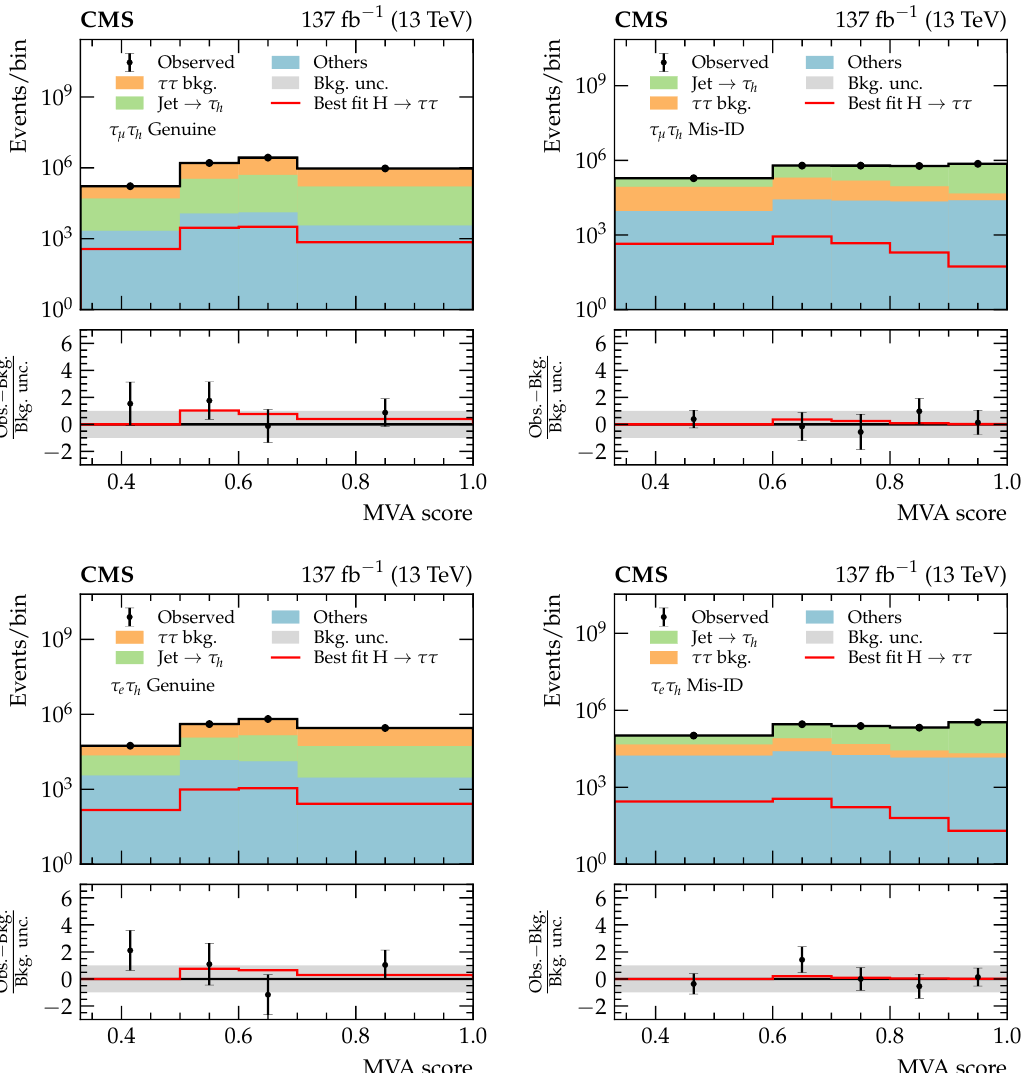
Figure 6 . The post-fit MVA score distributions for the Genuine (left) and Mis-ID categories (right) in the t t h (upper) and t e t h (lower) channels. The distributions are inclusive in t h decay mode. m The best fit signal distributions are overlaid, where the signal cross sections are set to the values obtained from the fit to data, which are given in section 12.1. In the lower panels, the data minus the background template divided by the uncertainty in the background template is displayed, as well as the signal distribution divided by the uncertainty in the background template. The uncertainty band accounts for all sources of systematic uncertainty in the background prediction, after the fit to